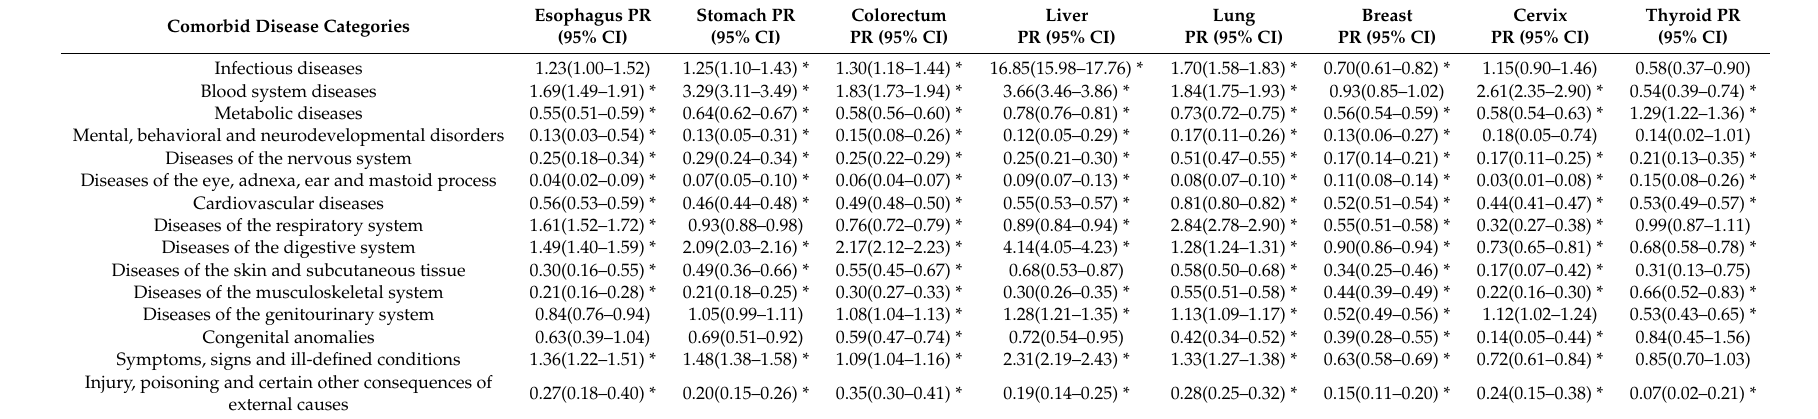
Table 3. Prevalence ratios of co-morbid diseases in elderly patients with specific